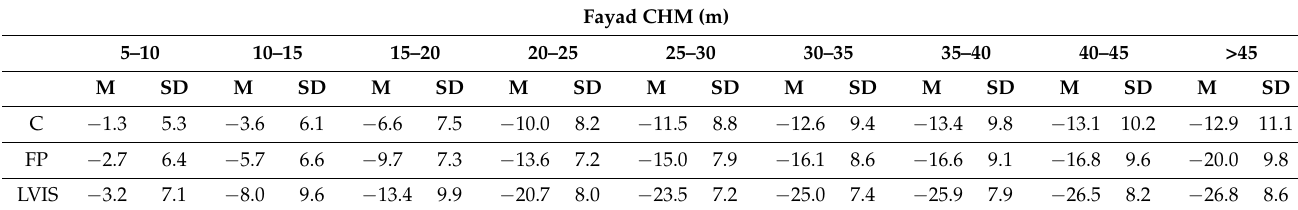
Table A3. Mean (M) and standard deviation (SD) in meters of the elevation difference between ELM and SRTM for shots with a sensitivity ≥ 98%. (C) and (FP) correspond to the ELM values from GEDI’s coverage and full-power lasers, respectively. (LVIS) corresponds to the ELM values from LVIS.